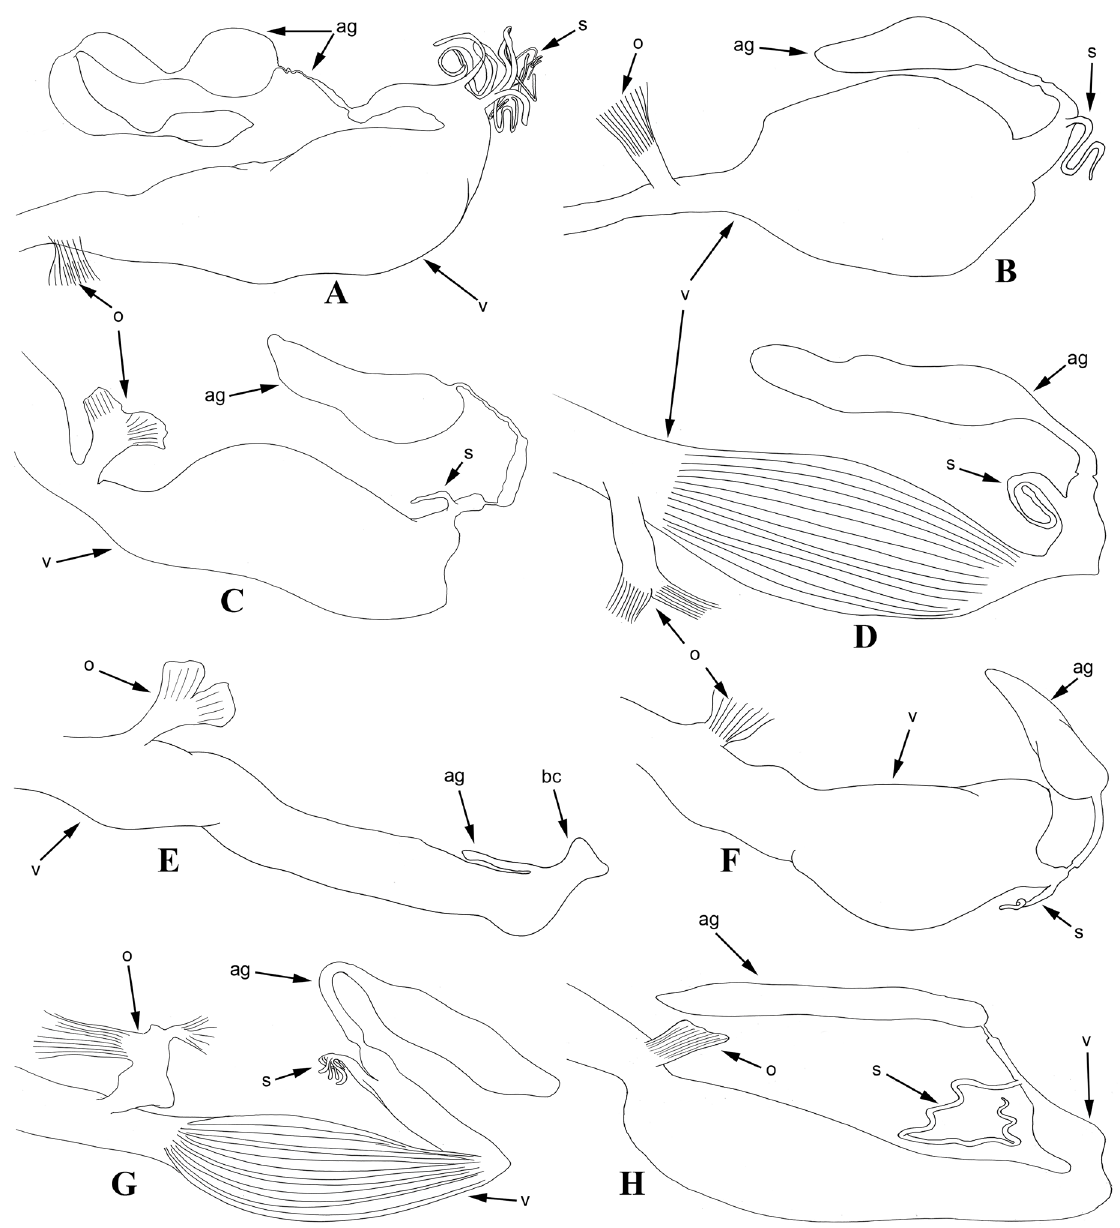
Fig. 23. Female genital ducts of Pimeliini. A . Apatopsis grombczewskii Semenov, 1891 (ZIN). B . Habrobates vernalis Semenov, 1903 (ZIN). C . Dietomorpha pardalis Kühnelt, 1957 (ZIN). D . Przewalskia dilatata (Reitter, 1887) (ZIN). E . Mantichorula semenowi Reitter, 1889 (ZIN). F . Platyope leucogramma (Pallas, 1773) (ZIN). G . Platyope grumi (Semenov, 1893), paralectotype (ZIN). H . Earophanta serrata (Semenov, 1893) (ZIN). Not to scale. Abbreviations: see Material and